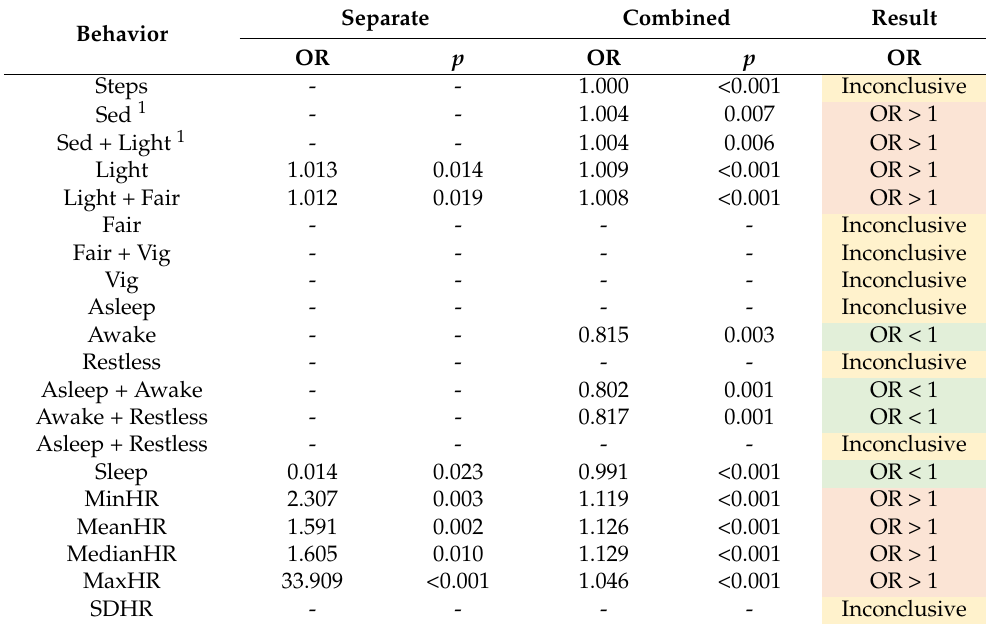
Table A10. Results across all conditional logistic regression models in validation scenario type